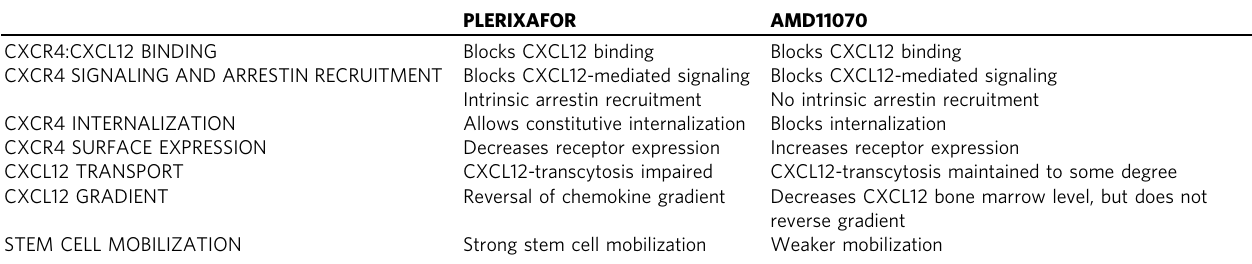
Table 1 Effects of plerixafor vs AMD11070 on CXCR4, CXCL12, and stem cell